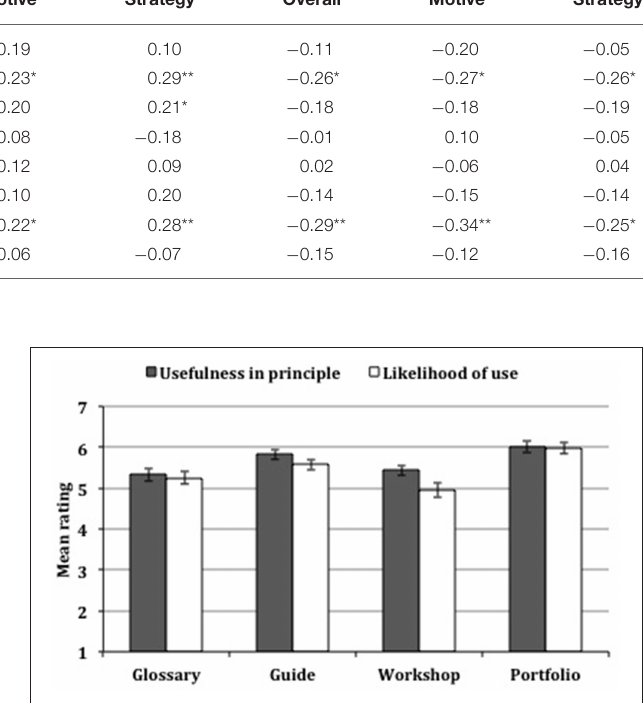
FIGURE 1 | Mean perceptions of each DEFT tool’s usefulness in principle, and likelihood of being used. Error bars are equal to ± 1 standard error of the